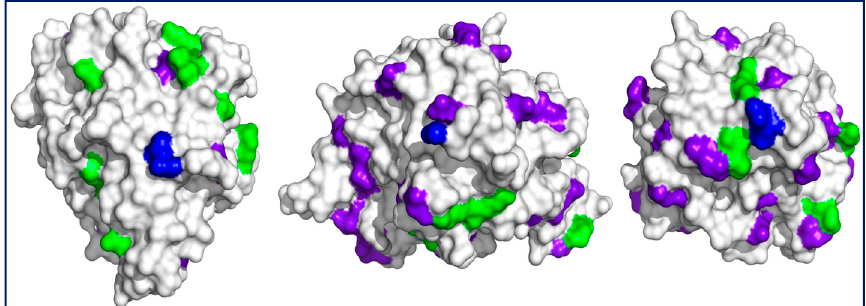
Figure 2. Surfaces of (left) CAL (PDB 5a71), (middle) BTL2 (PDB 2w22), and (right) TLL (PDB 1dte) centered at the (blue) N-terminus. Other surrounding residues which are potentially reactive at neutral pH with Gx are (green) lysyl ε -NH 2 groups and those amino groups added upon chemical amination (purple-blue) of glutamyl and aspartyl residues. In all cases, the active center is on an enzyme surface projection different from the one shown here. Notice the lower number of reactive residues for CAL. Representations made with Pymol version 1.3.